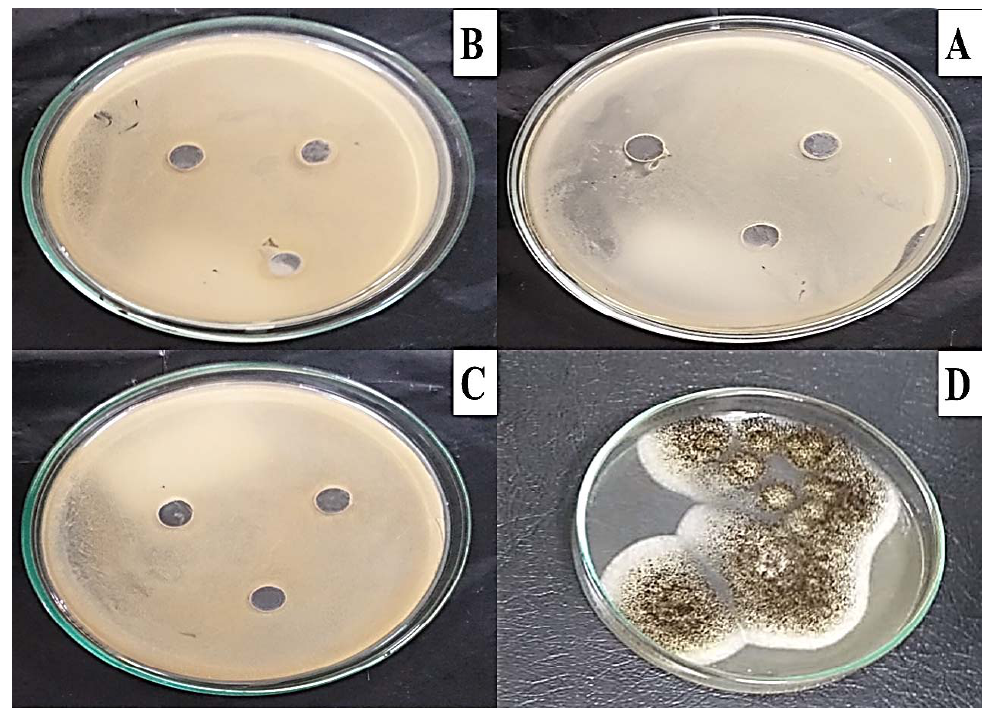
Figure 9. Microbial toxicity of MG biodegraded products against bacterial and fungal strains ( A ) S. aureus ATCC 29737, ( B ) E. coli ATCC 8379, ( C ) C. albicans ATCC 60193, and ( D ) A. niger ATCC 16,404 using the well diffusion method on Muller–Hinton agar indicating no inhibition growth for all